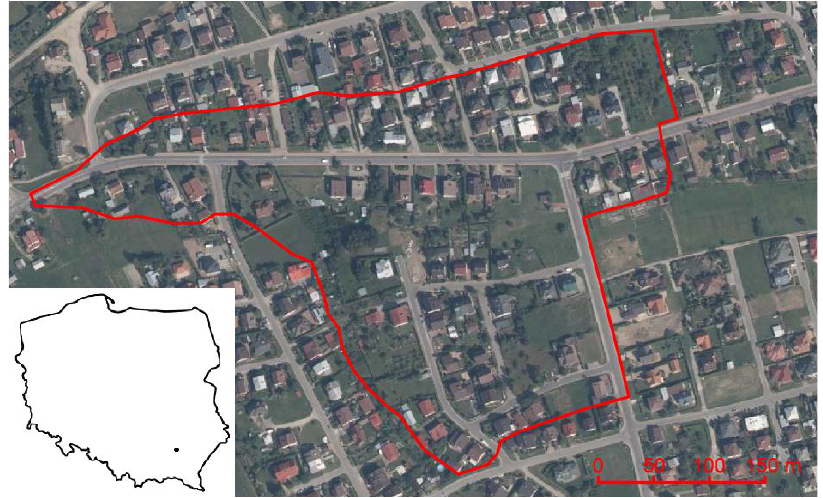
Figure 6. Location of the study area.